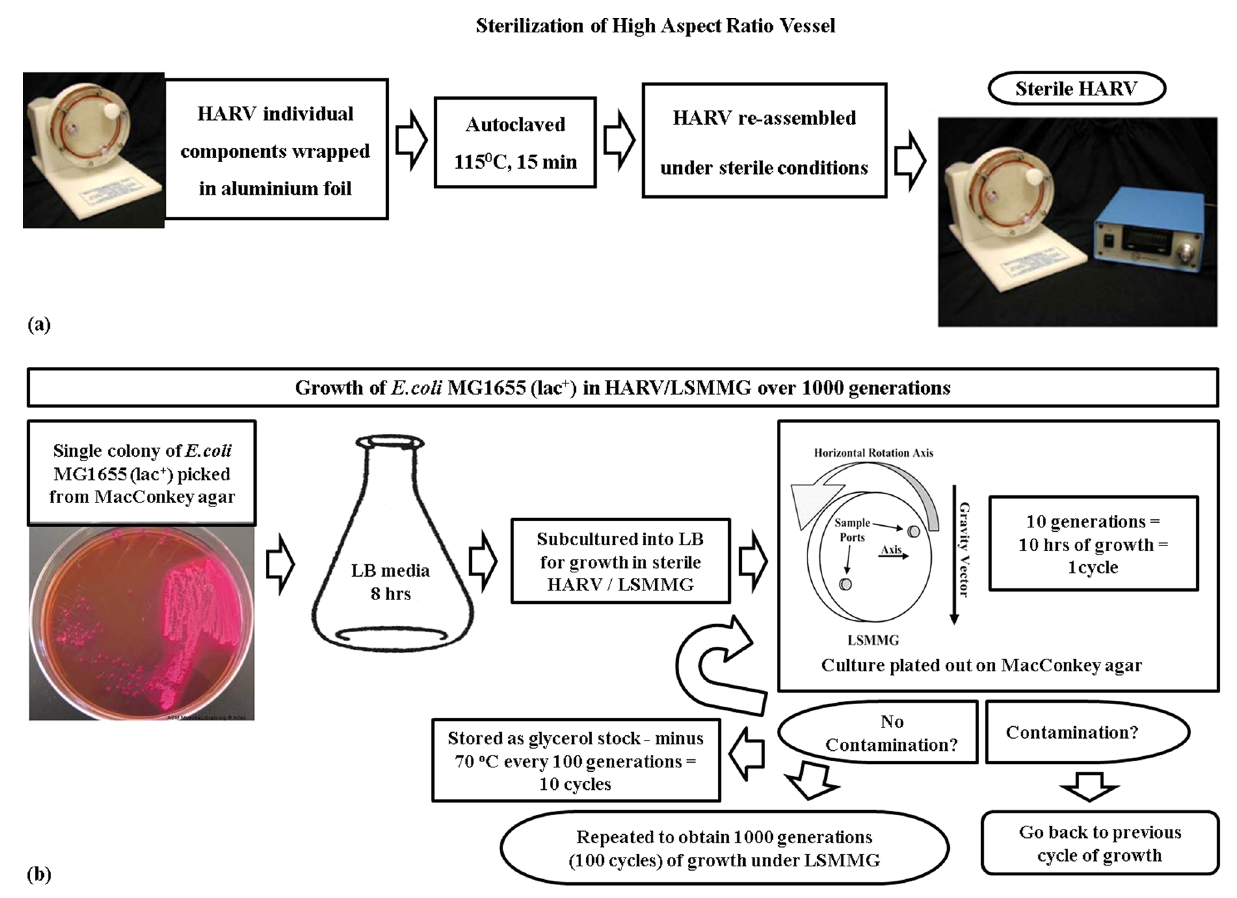
Fig. 3 Overview of growth procedures: ( a ) Sterilization protocol for the HARV(s); ( b ) Protocol for growth of E. coli MG1655 lac plus strain in the HARV(s) This fi gure was prepared by Madhan